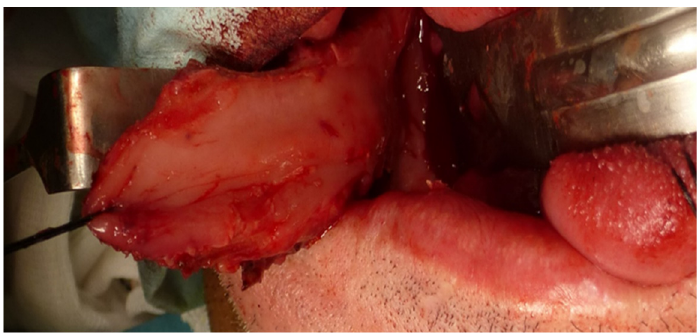
Figure 3. Right FAMM flap inferiorly pedicled with an anterograde flow on the facial artery.